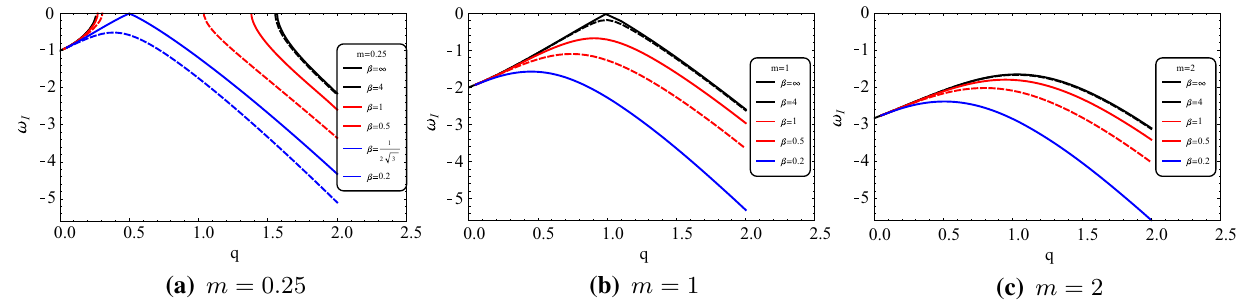
Fig. 8 The behavior of imaginary parts of QNMs ( ω I ) with respect to q for nonlinearly charged case